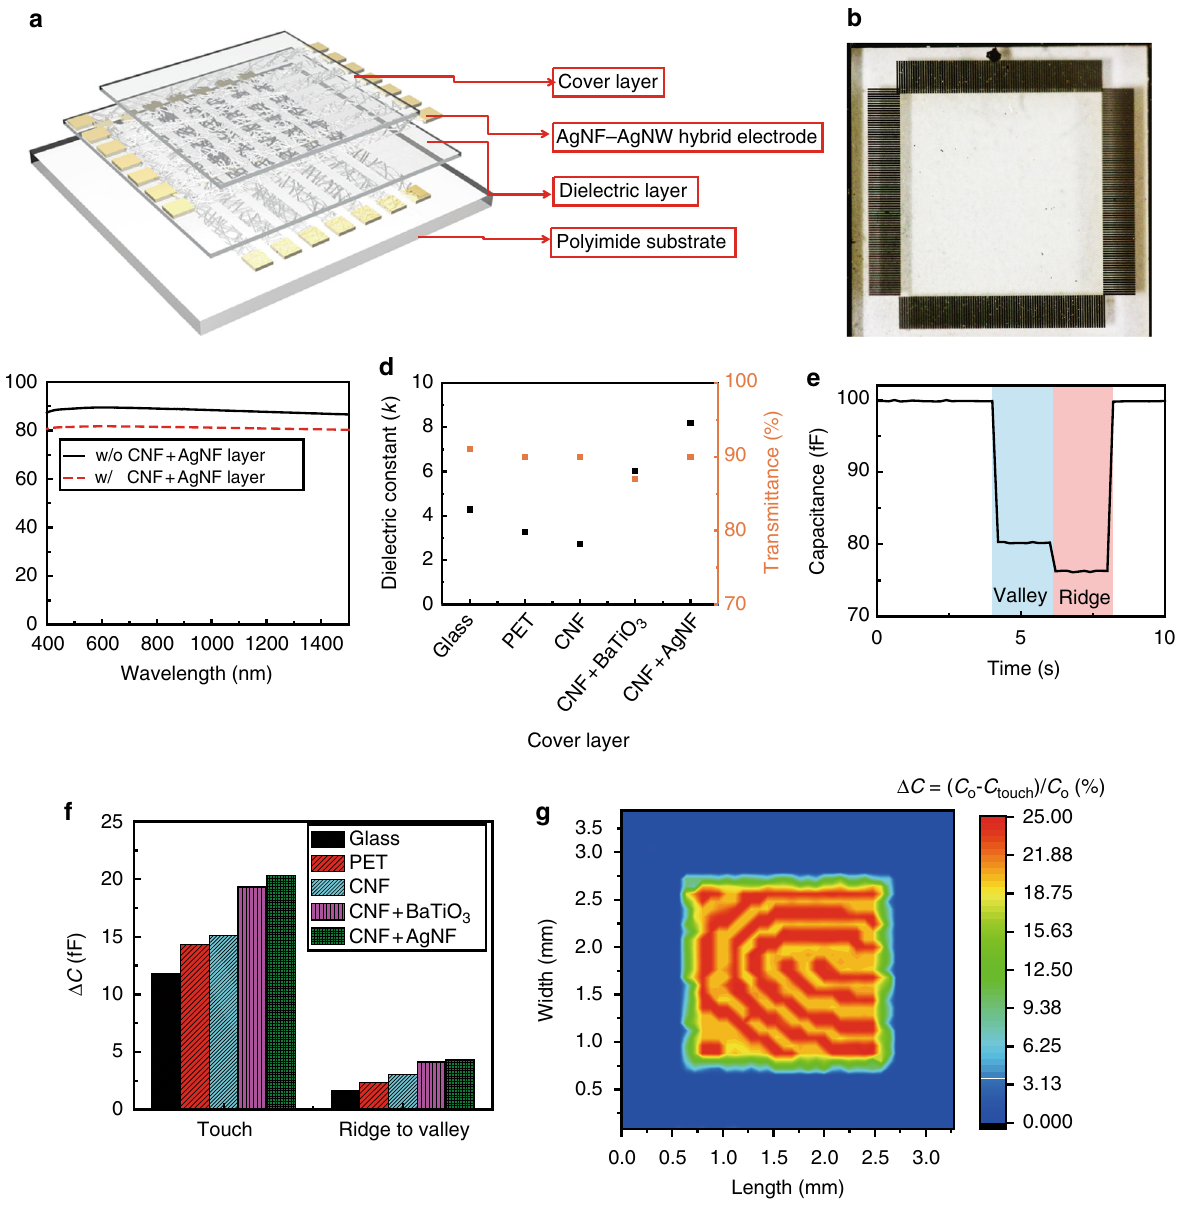
Fig. 3 Flexible, transparent fi ngerprint sensor. a Schematic illustration of the fi ngerprint sensor structure. b Photograph of the transparent fi ngerprint sensor. Scale bar, 1 mm. c Optical transmittance spectrum of the transparent fi ngerprint sensor (w/ and w/o cellulose nano fi ber (CNF) – AgNF layer, thickness: 100 μ m). d Optimized transmittance at the wavelength of 550 nm and a dielectric constant at a frequency of 1 MHz with various cover layer fi lms. e Real-time single-cell capacitance change according to the ridge – valley position change. f Capacitance change depends on the fi ngerprint ridge and valley with various cover layers. g Captured 2 mm × 2 mm fi ngerprint